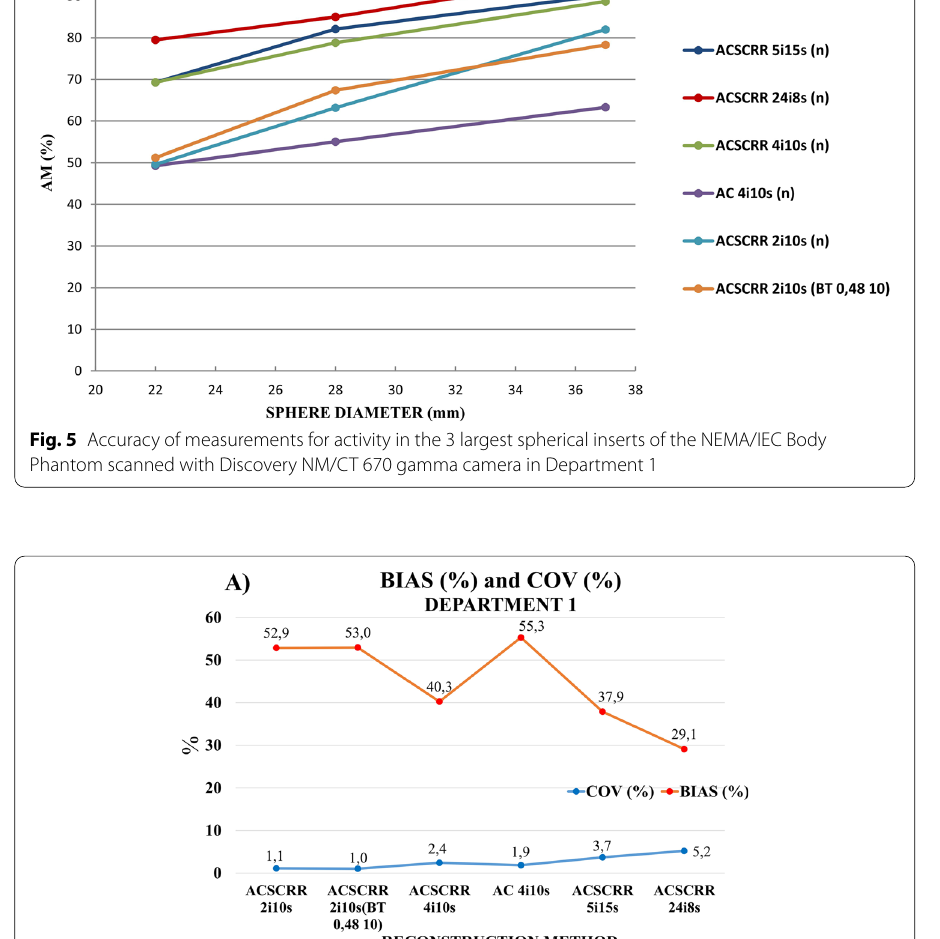
decrease in noise was recorded for the 2 iterations 10 subsets method with the Butter- worth reconstruction filter, as well as for the 4 iterations 10 subsets method without SC and RR corrections. The introduction of the filter to the reconstruction method with 2 iterations slightly reduced the noise level in the images (by 0.1% on average) with simul- taneous increase in the averaged BIAS.